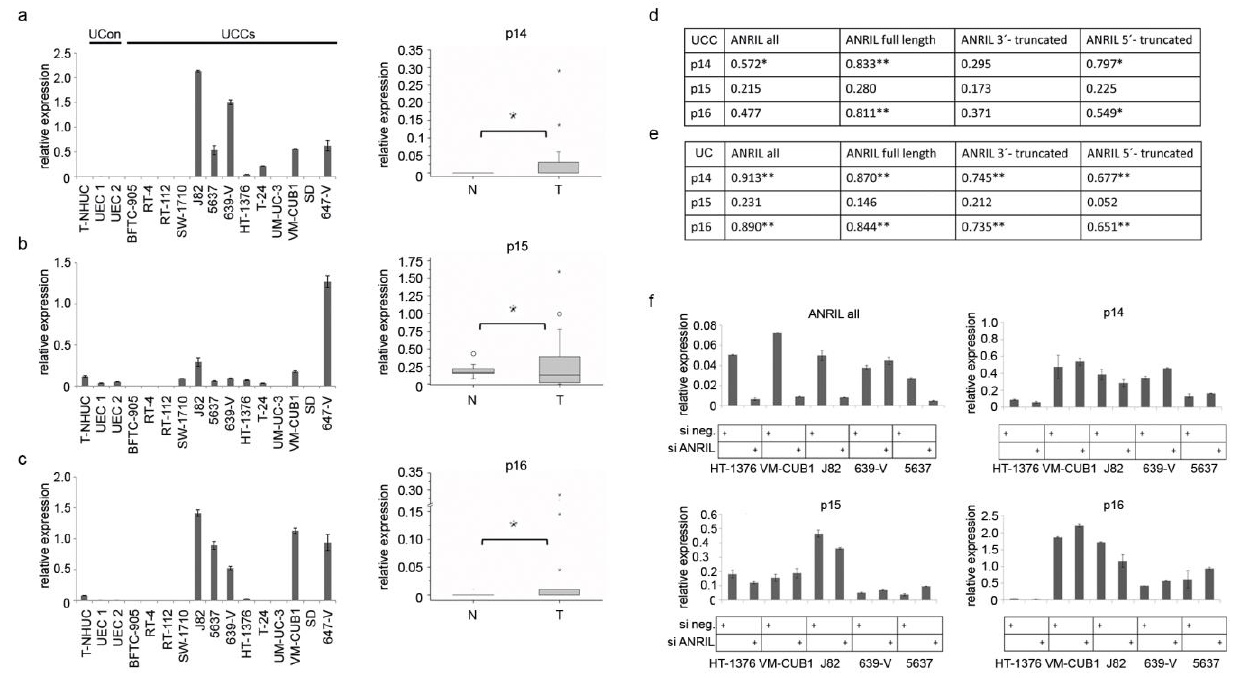
Figure 3. ( a – c ) Expression profiles of the three TS from the INK4 / ARF locus were generated by qRT-PCR in UCCs (left panels) and tissue set 1 (boxplot graphs right panel; * p ≤ 0.05; T: n = 19; N: n = 10). Expression of different ANRIL variants was correlated with expression of the three TS in cell lines ( d ) and tissues ( e )( ** p ≤ 0.01; * p ≤ 0.05). ( f ) Knockdown of full length and truncated ANRIL variants by siRNA (top left panel) did not result in significant expression changes of the three TS in four different UCCs. SiRNA knockdown of ANRIL in 639-V cells was less